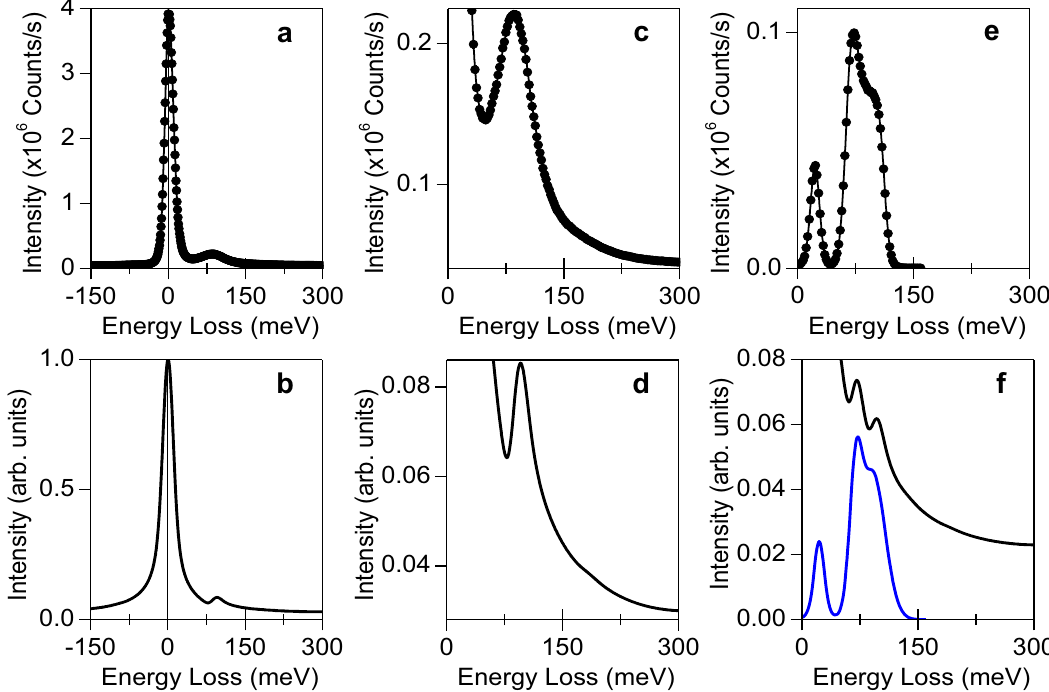
Fig. 2 The measured and calculated electron energy-loss spectra. a The measured spectrum near the (cid:1) Γ -point ( q = 0 Å − 1 ) at an electron energy of E = 4.0 eV. b The calculated loss spectrum at the same geometry and incident energy, as described in the text. The magni fi ed spectra are shown in c , d , i respectively. e The measured and f the calculated spectra at the (cid:1) M-point. The peak at about 22 meV is an optical phonon. The two peaks at higher energies are the plasmonic excitations. The black curve in f is the calculation including the elastic peak. In the blue curve, the elastic contribution is removed. Note that in the spectra presented in a , c , e the error bars are also shown. Since they are smaller than the symbol size, they are not visible. The error bars represent the statistical uncertainties of the measured count